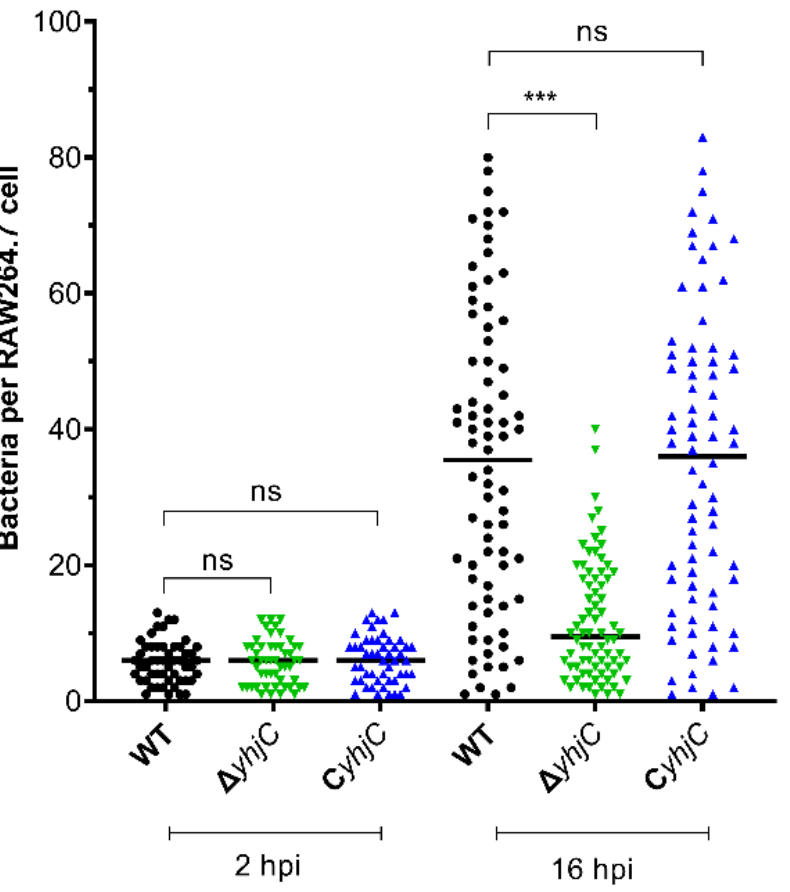
Figure 2. Numbers of S. Typhimurium cells in single RAW264.7 cell. At least 50 RAW264.7 cells in random fields were used to count the numbers of S. Typhimurium at 2 and 16 hpi. The p values were calculated by unpaired Student′s t test. *** p < 0. 001; ns, not significant. A representative image of RAW264.7 cells infected by S. Typhimurium at 16 hpi visual- ized the difference in the bacterial numbers between WT, ∆ yhjC, and CyhjC (Figure 3). The number of WT Salmonella cells was significantly higher than that of ∆ yhjC, and the comple- mented strain CyhjC showed comparable numbers of bacterial cells to WT. Moreover, the numbers of macrophages infected by WT, ∆ yhjC, and CyhjC did not significantly change. These results further suggested that yhjC contributed to the survival and replication of S. Typhimurium in